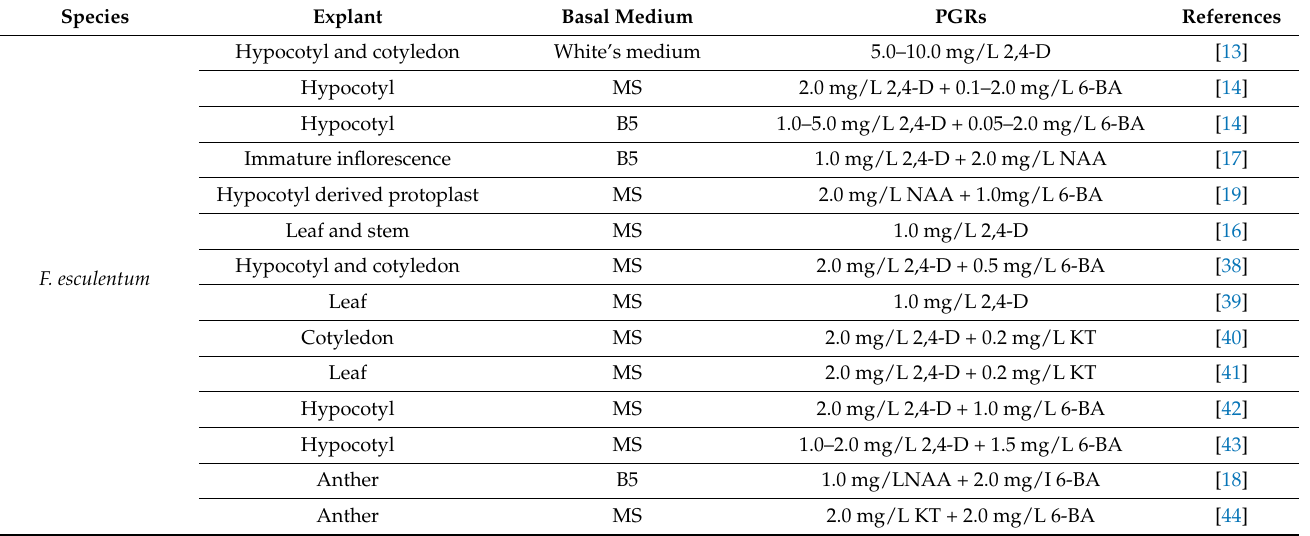
Table 1. Optimal conditions for the callus induction from different explants in F. esculentum and F. tataricum . Species Explant Basal Medium